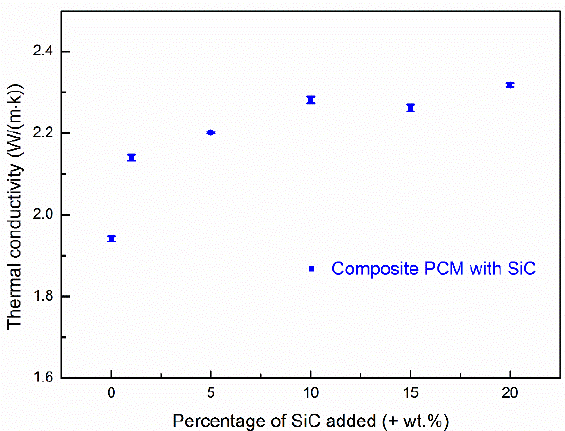
Figure 2. The thermal conductivity of composite PCMs with different SiC contents using a mass ratio of salt to MgO of 60:40.